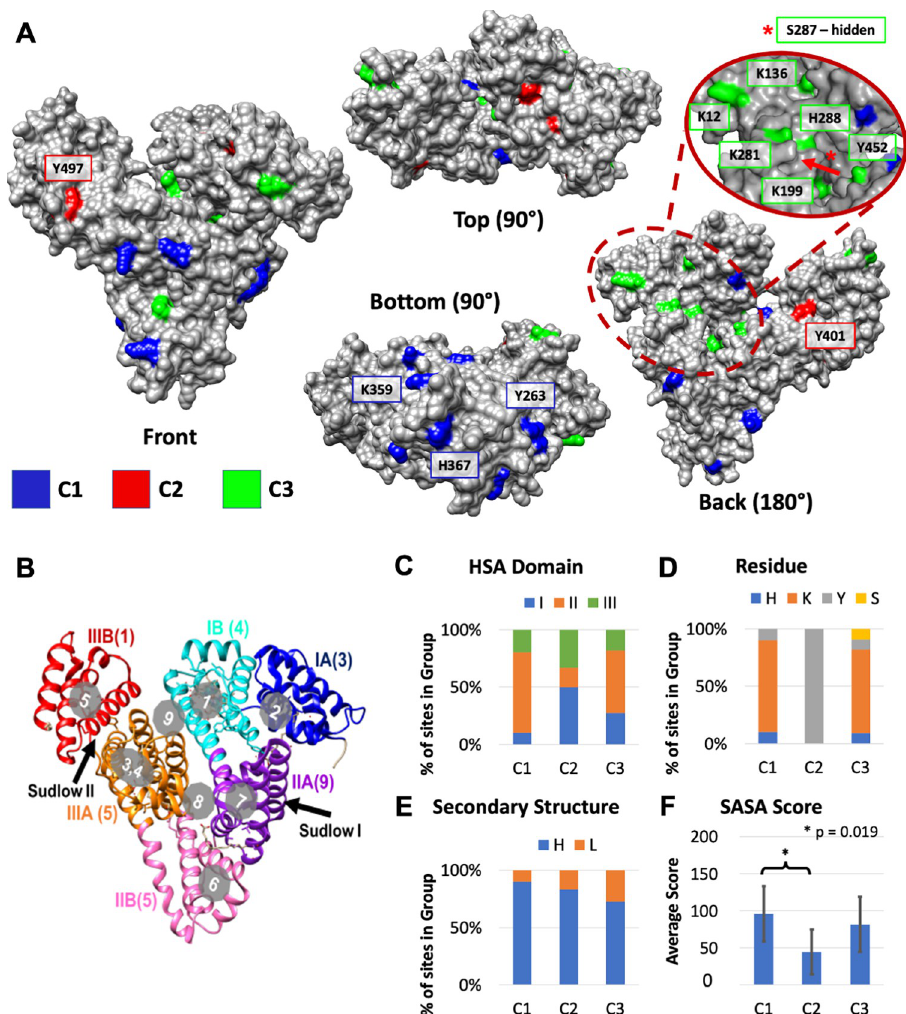
Fig 6. Characterizing AEBSF modification site of the 3 clusters (C1, C2, C3) on HSA. (A) A representative HSA crystal structure (PDB ID: 1N5U) with the 3 AEBSF modification sites clusters colored. The three clusters, C1, C2, and C3 are colored in blue, red, and green, respectively. Individual C1 and C2 sites that are significantly less accessible in RA HSA are labeled. The red oval indicates a C3-rich region in domain I that could be a plausible binding site for RA- specific interactions that most likely to increase HSA stability. (B) The HSA structure is colored by its 3 domains (I, II, III), and subdomains (A, B). The number of AEBSF modification sites regardless of cluster designation in each subdomain is listed in parentheses. The 9 known cargo binding pockets are shown in the gray circles, and the two drug binding sites, Sudlow I & II, are shown by an arrow. The four bottom-right panels show what percentage of the AEBSF sites in each cluster (C) is in each HSA domain, (D) is on each amino acid residue, (E) has each secondary structure (Helix (H) or Loop (L)), and (F) the average SASA score of each cluster. Only SASA scores between C1 and C2 are statistically different (p =